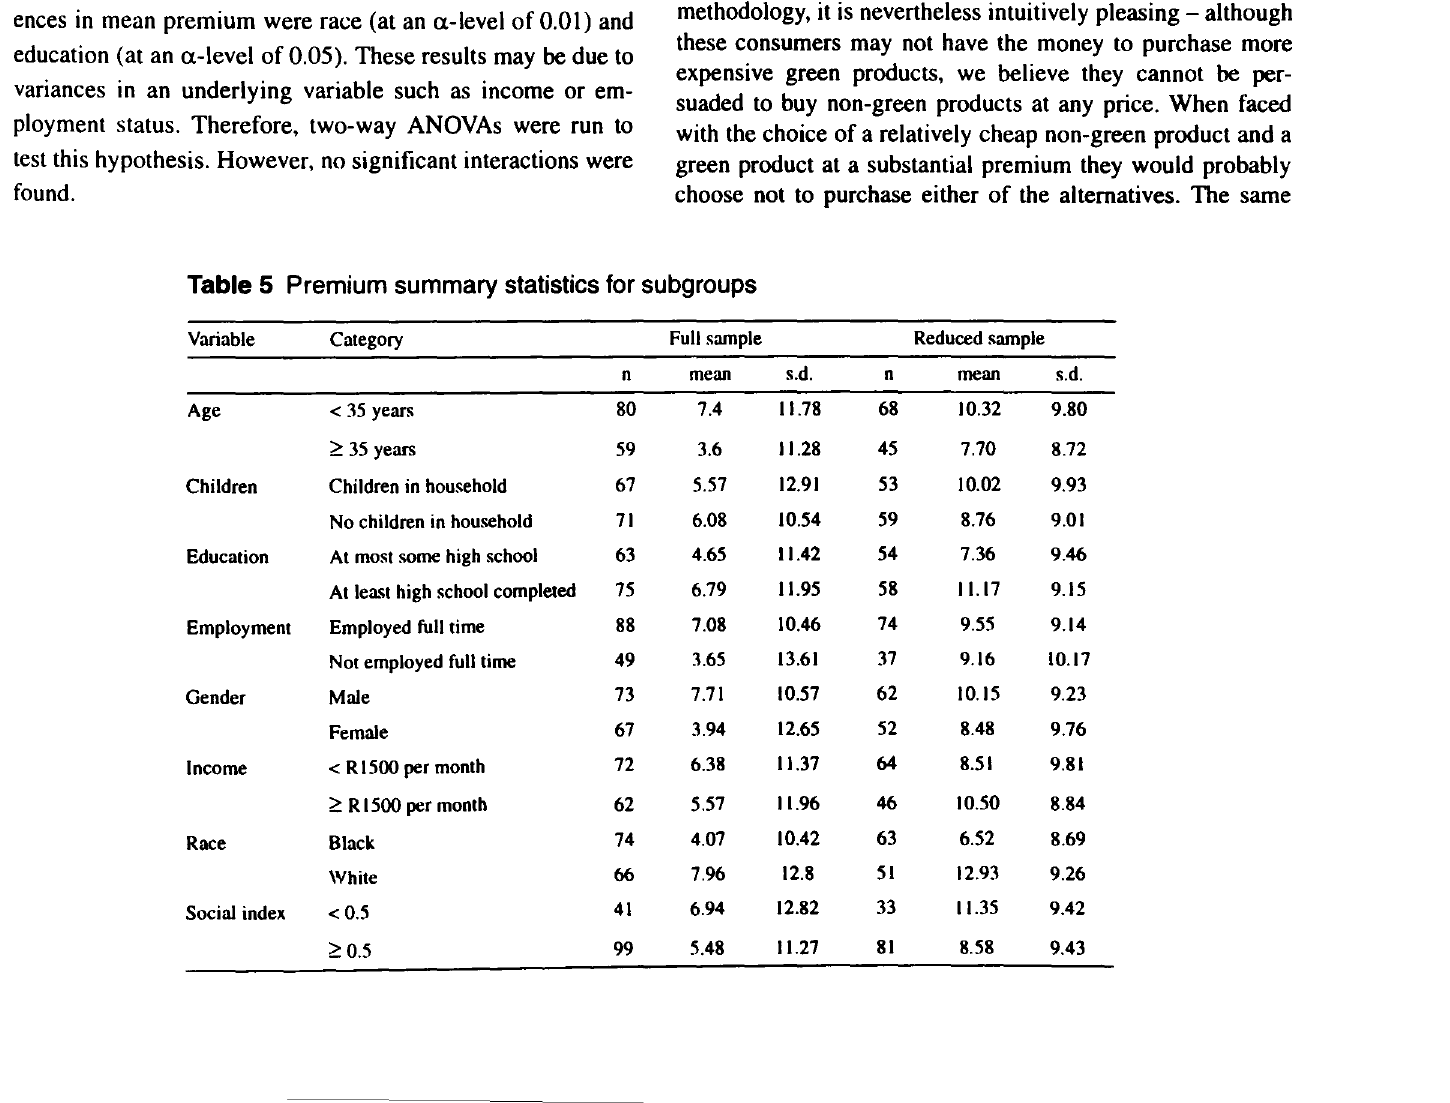
Table 5 Premium summary statistics for